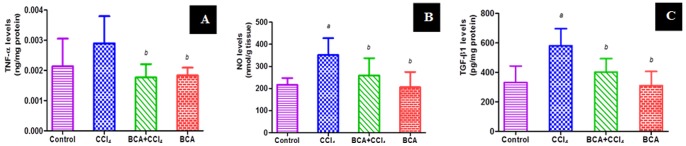
Effect of BCA on TNF-α, NO and TGF- β1 levels.(A) TNF-α expression levels; (B) NO levels; (C) TGF- β1 expression levels. a: significantly different from control gp. b: significantly different from CCl4 gp.